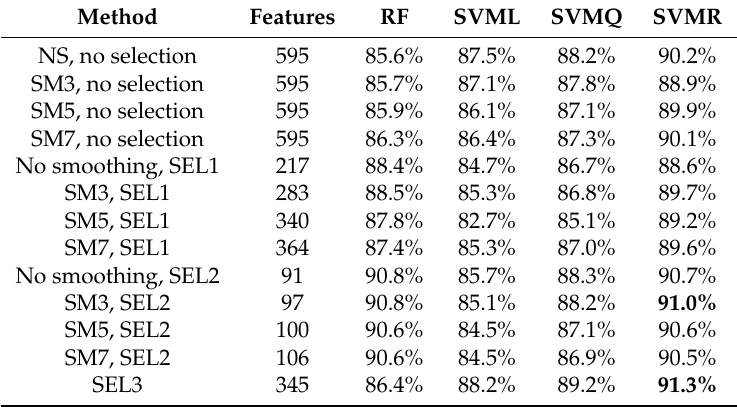
Table 3. Classification accuracy for speed changes for feature vectors describing trends, depending on feature selection and smoothing. NS: no smoothing. The two best results are shown in